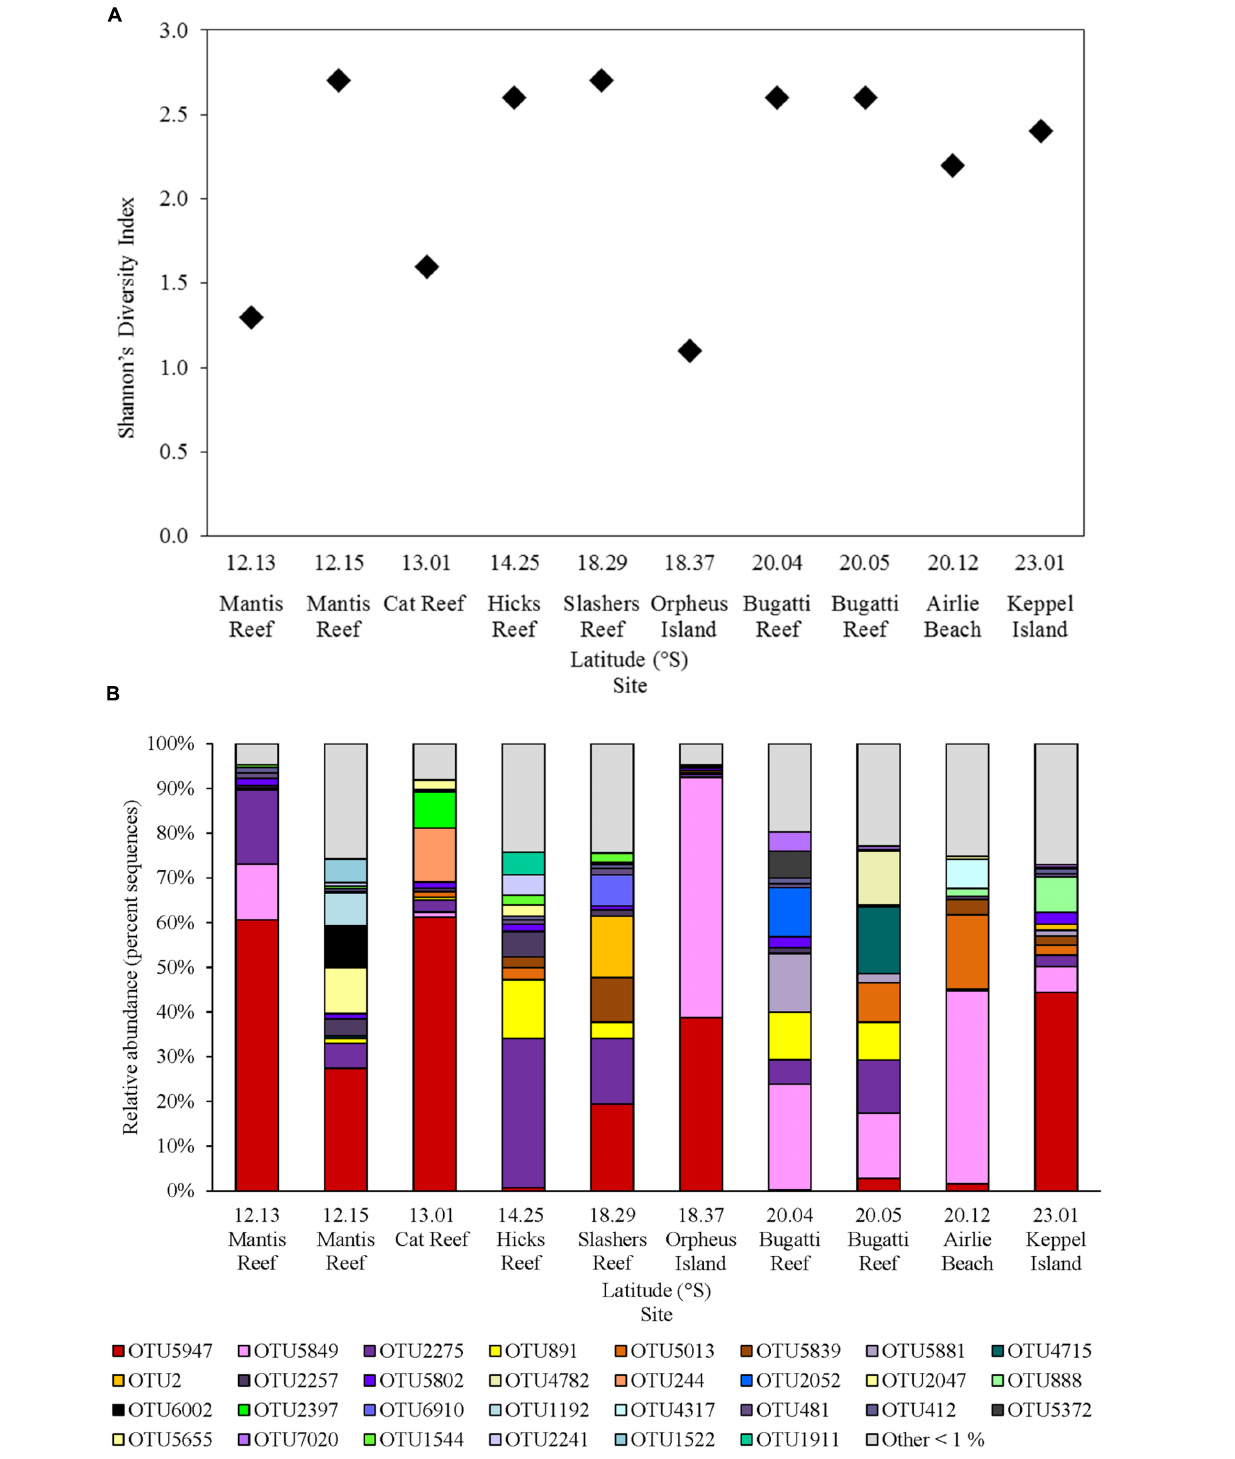
Frontiers in Microbiology |